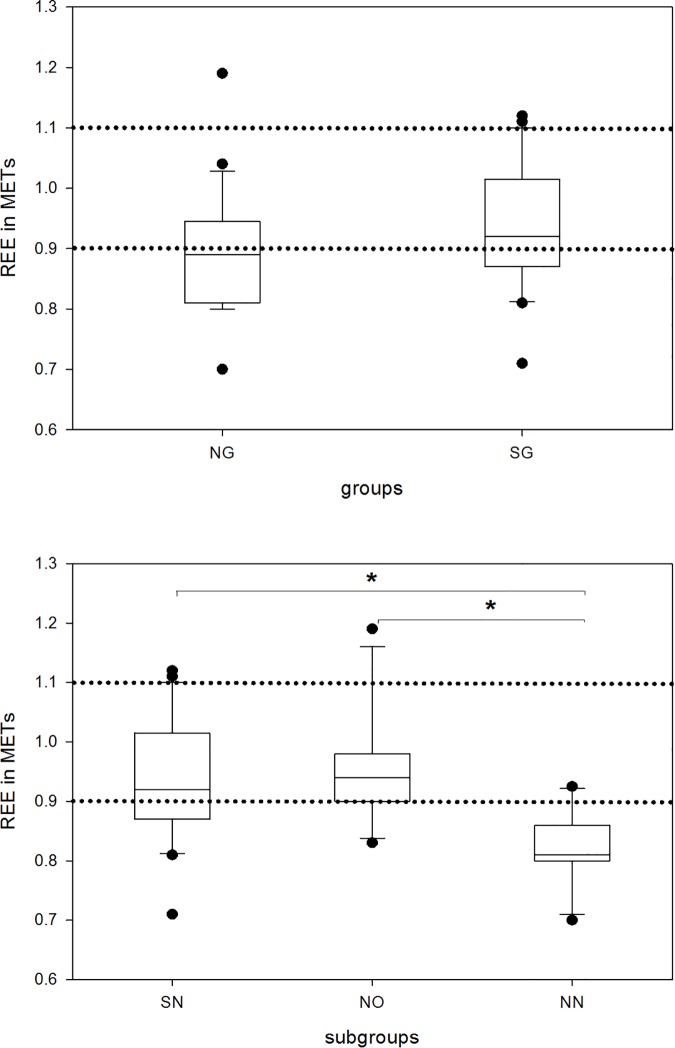
Boxplot of Resting Energy Expenditure (REE) in METS by groups and subgroups.The boxes cover the first quartile on the bottom and the third quartile on the top. Whiskers reach from the minimum to the maximum value excluding outliers (illustrated by dots). Shift-working group and shift-working nursing-staff subgroup cover identical cohorts. The dotted lines bounds the limits for hypermetabolic state (REE>1.1 METs) and hypometabolic state (REE<0.9 METs). NG, non-shift-working group; SG, shift-working group; SN, shift-working nursing-staff subgroup; NO, non-shift-working office-staff subgroup; NN, non-shift-working nursing-staff subgroup *p<0.05